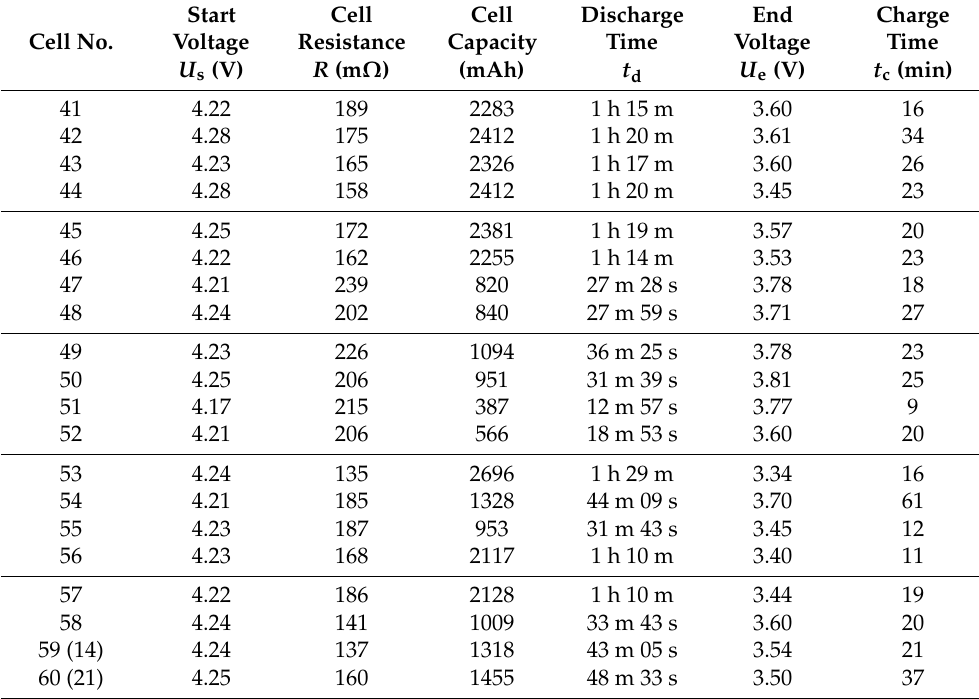
Table 5. Reused cell capacities determined with the discharging method (discharged with 1.8 A).